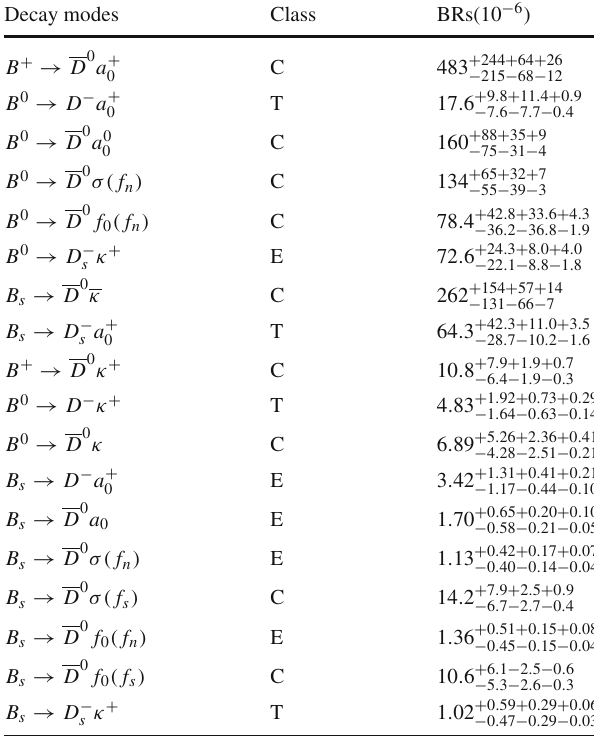
Table 1 Branching fractions of B q → DS ( a 0 ( 980 ),κ,σ, f 0 ( 980 )) decays calculated in the PQCD approach in S1 Decay